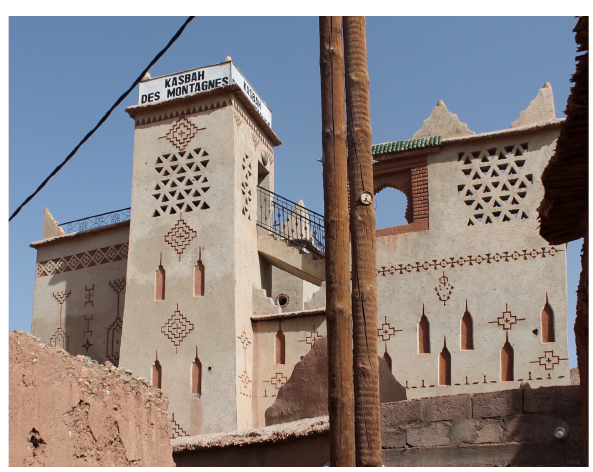
Figure 18. “Kasbah des Montagnes”, Bou Taghrar.